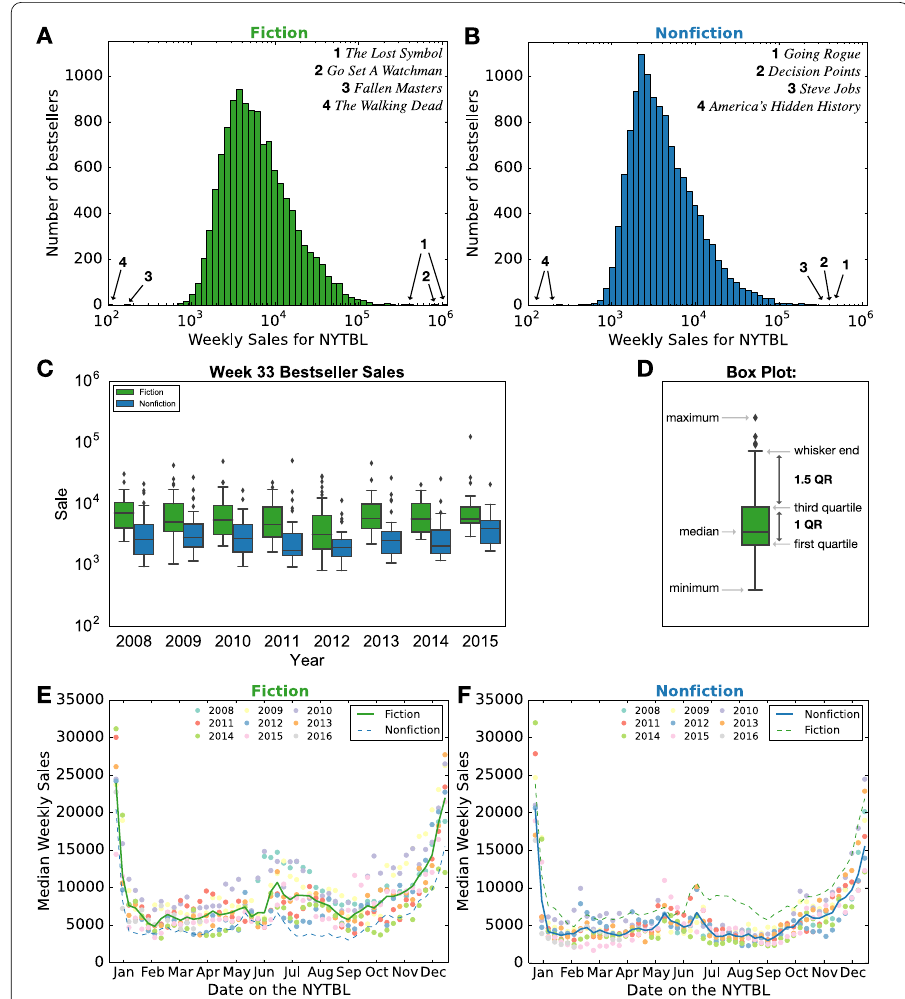
Figure 4 MakingtheNYTBL . The distribution of the number of copies sold in a week needed to be featured in NYTBL for ( A ) fiction and ( B ) nonfiction. ( C ) The number of copies bestselling books have sold in a single week in mid August (week number 33) that got them to the list over different years. ( D ) Explanation of the box plot technique used in ( C ). The median number of copies the bestselling books sold to hit the NYTBL during different weeks throughout a year, for ( E ) fiction and ( F ) nonfiction. In general, books need to sell between 1000 and 100,000 copies in a single week to hit the NYTBL, a range that has been fairly stable over the years. Fiction book sales are higher in summer and all sale numbers are significantly elevated from December to early January. Fiction sells more than nonfiction throughout the year but the gap is smallest in early January